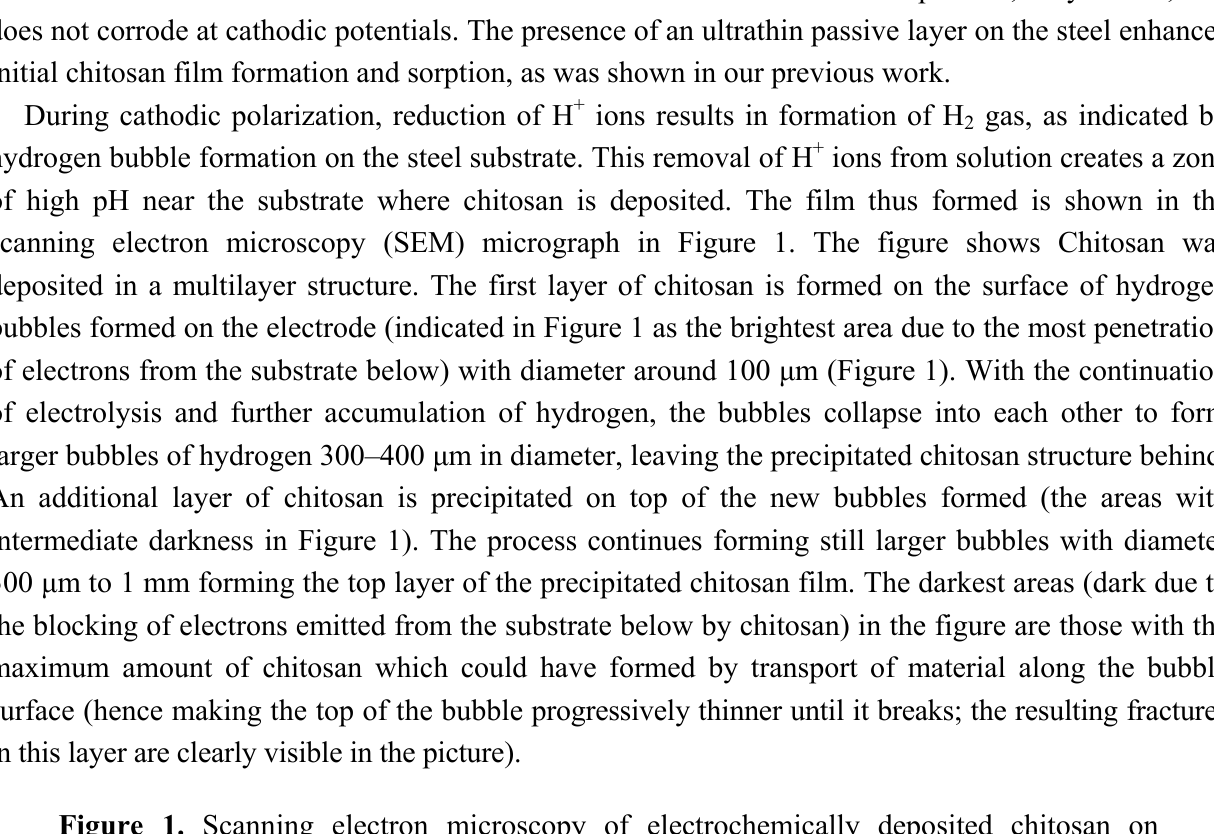
Figure 1. Scanning electron microscopy of electrochemically deposited chitosan on stainless steel at − 3.0 V vs . Ag/AgCl reference